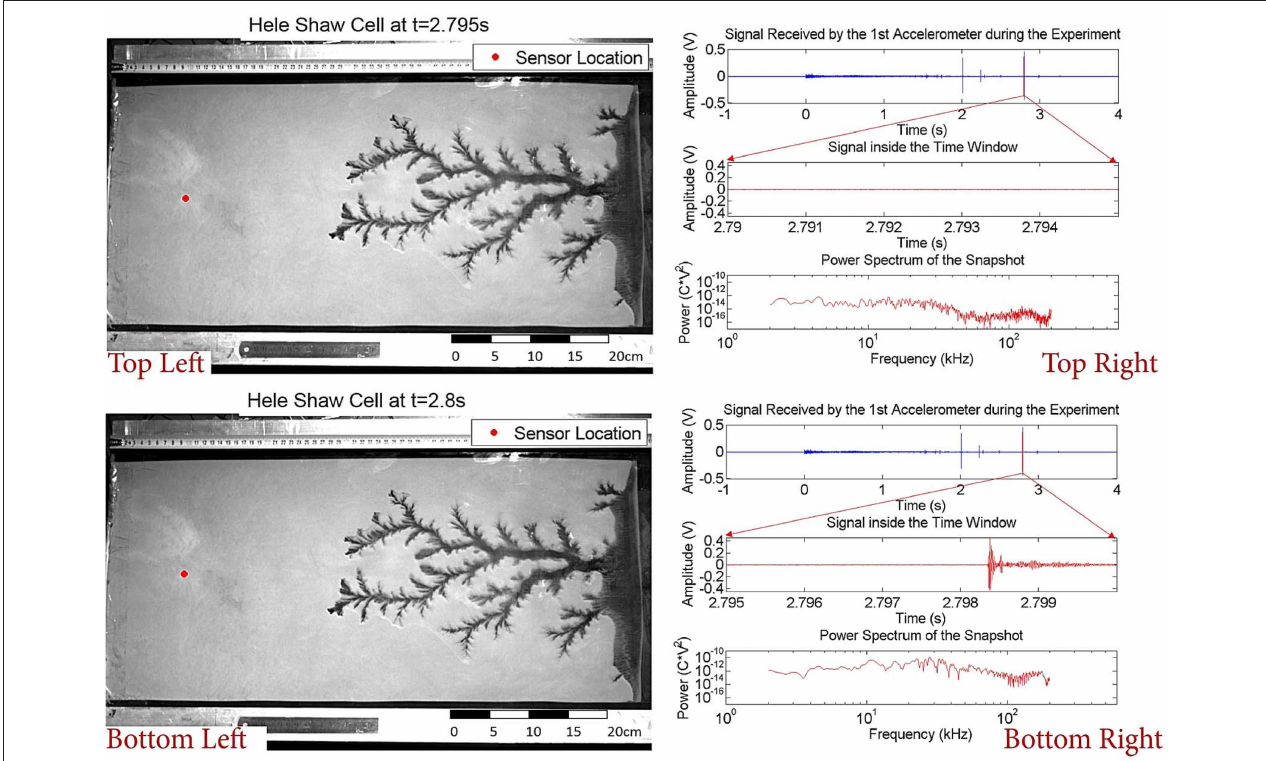
FIGURE 10 | Optical (Left) and acoustic (Right) experimental recordings just before (Top) and during (Bottom) an aftershock like event. The red dot on the left image illustrates the sensor location where the signal on the right is recorded. Top Right: Acoustic signal recorded throughout the entire experiment. The red strip (time window of 0.005s) corresponds to the snapshot that the image (Left) and power spectrum (Right) occurred at.